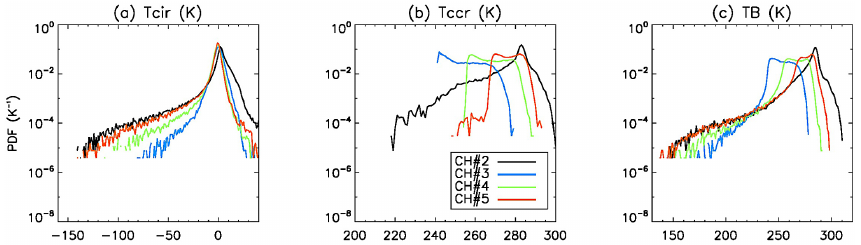
Figure 1. Probability density functions of T cir (a) , T ccr (b) and T B (c) for CH#2 (black), CH#3 (blue), CH#4 (green) and CH#5 (red). Samples are from the NOAA-18 MHS nadir view during August 2010 in the tropics ([25 ◦ S, 25 ◦